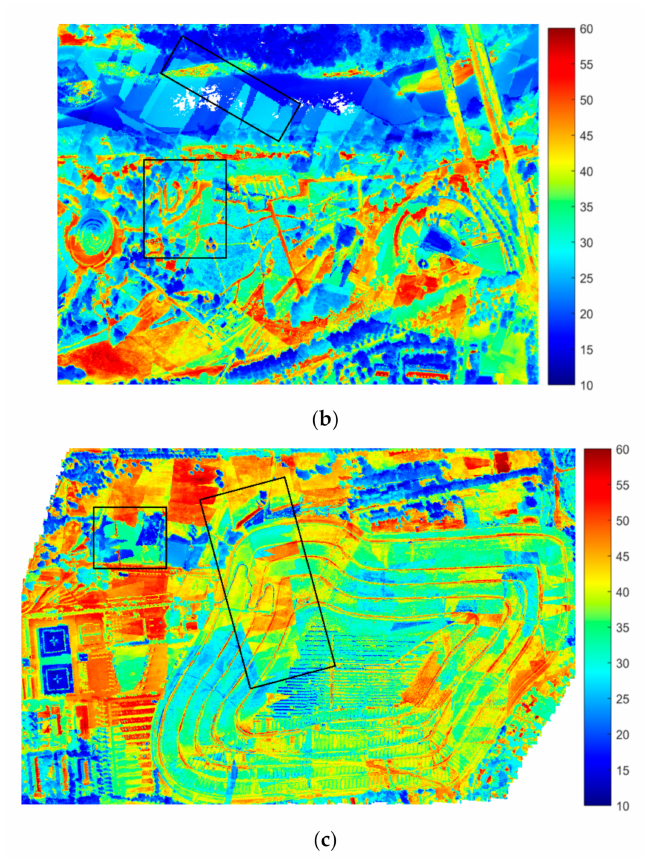
Figure 7. Thermal texture mapping results ( ◦ C) using strategy 1 for ( a ) building area, ( b ) river ecosystem, and ( c ) soil area.